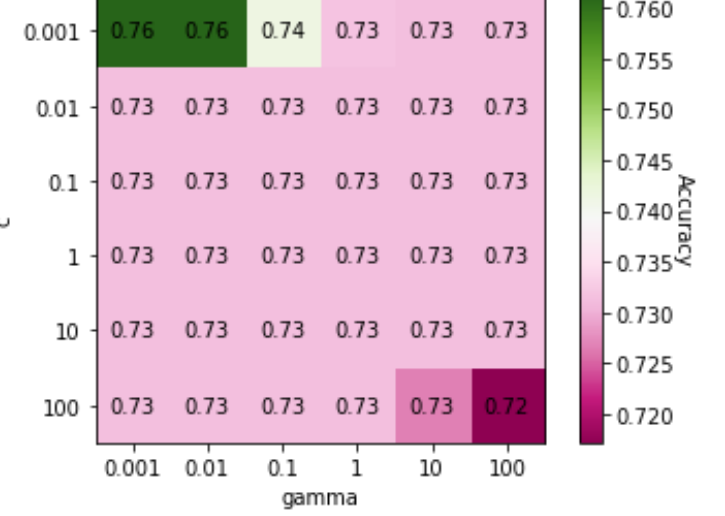
Figure 11. Heatmap of values of SVM parameters C and γ on Dataset 06 when classification was based on smoking habits.